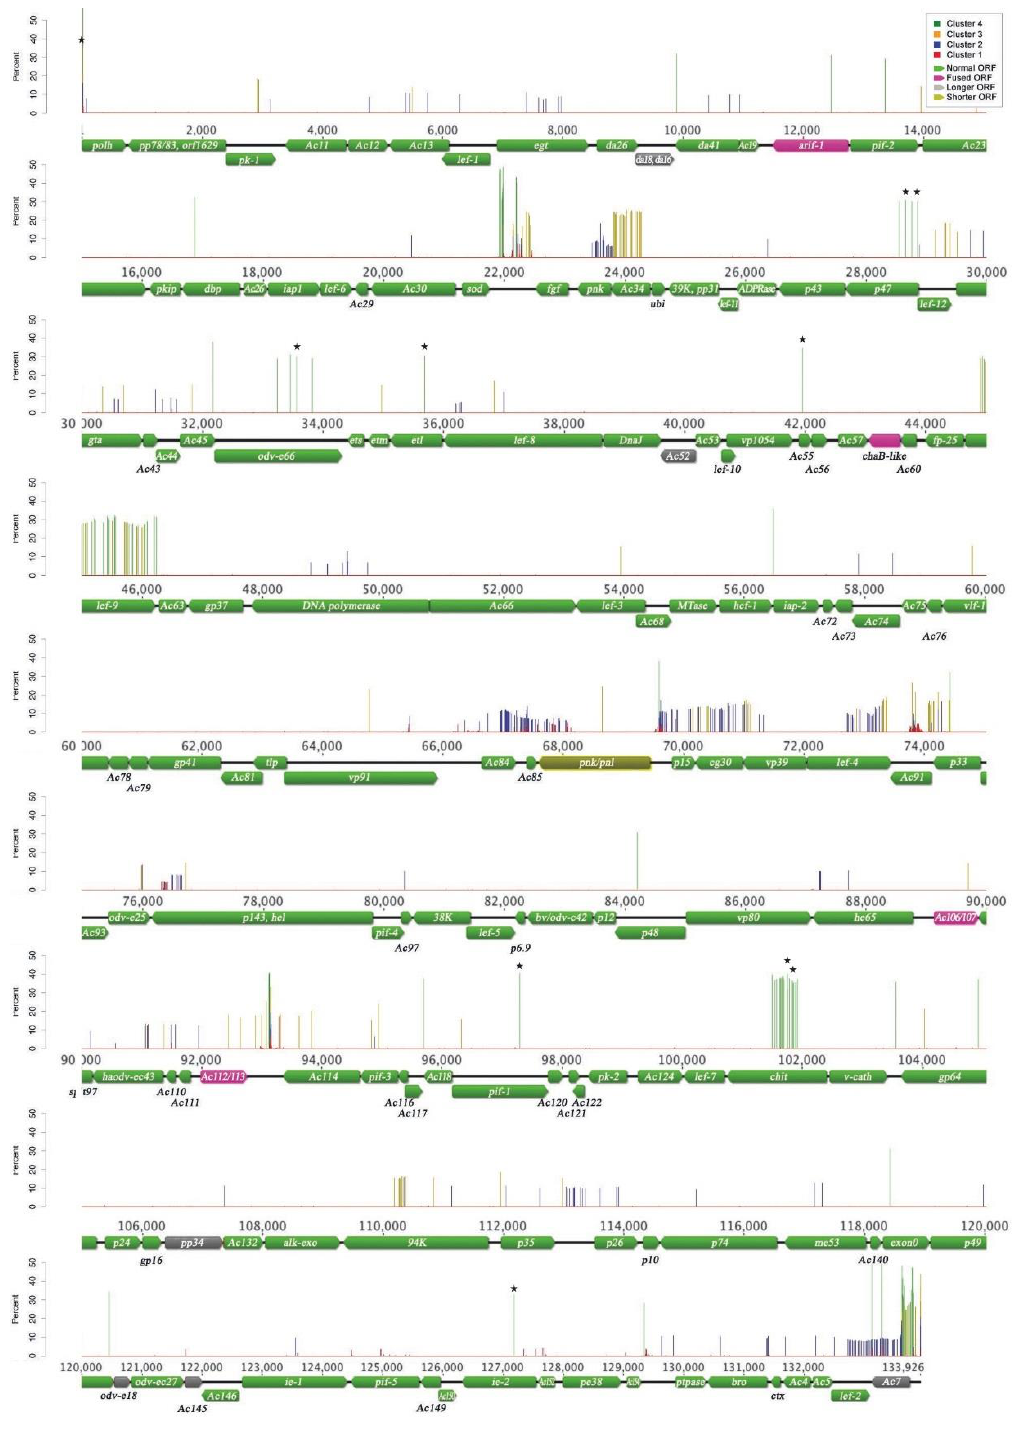
Figure 3. Location and frequency of non-consensus single nucleotide polymorphisms (SNPs) on the AcMNPV-WP10 consensus genome. The WP10 consensus genome is presented as a linear map. Arrows indicate the transcriptional direction of predicted ORFs. Arrows are colored according to the comparison of the WP10 and C6 AcMNPV genomes (green: ORFs with identical size in both genomes; pink: ORF fusion; grey: longer ORF, yellow: shorter ORF; see Table 1 for details). Non-consensus SNPs are plotted as frequency at the locus they were identified with a color corresponding to the k-means cluster they belong to (Table 2). Stars highlight cluster 4 SNPs changing amino acid polarity.